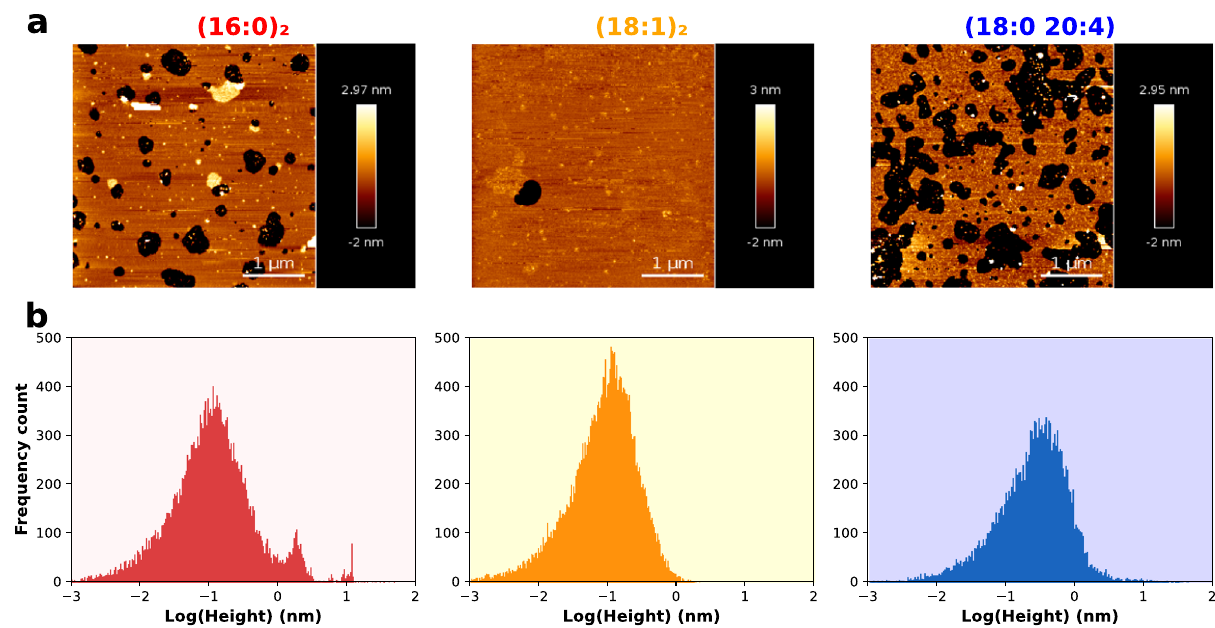
Fig. 2 Cation-induced clusters are formed independently of PI(4,5)P 2 acyl-chain composition, as seen by AFM measurements of supported lipid bilayers. PI(4,5)P 2 cluster formation was detected through the AFM measurement of SLBs containing DOPC and 5% PI(4,5)P 2 . Experiments were carried out for the three PI(4,5)P 2 species in study and fi gures are labeled according to the acyl-chain composition of the PI(4,5)P 2 species employed. Topographical images were acquired ( a ) and analyzed with fi rst- or second-level fl attening, using the JPK data processing software, from which the membrane heigh pro fi les ( b ) were obtained. Dark patches correspond to defects in the supported membrane. The height values of each pixel (higher than 0 nm) were transformed into log 10 value, avoiding the in fl uence of the height values of defects on the histograms. The frequency count axis represents the number of data points grouped into each bin on the height